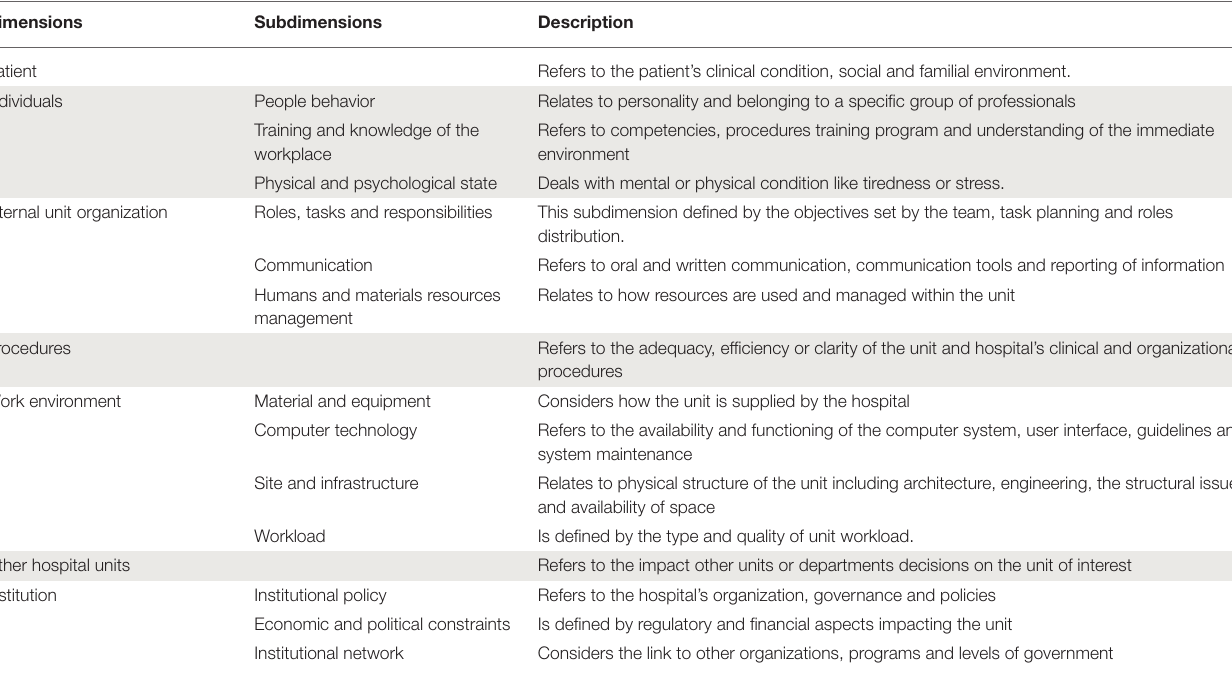
TABLE 1 | Debriefing and Organizational Lessons Learned (DOLL) framework dimensions and